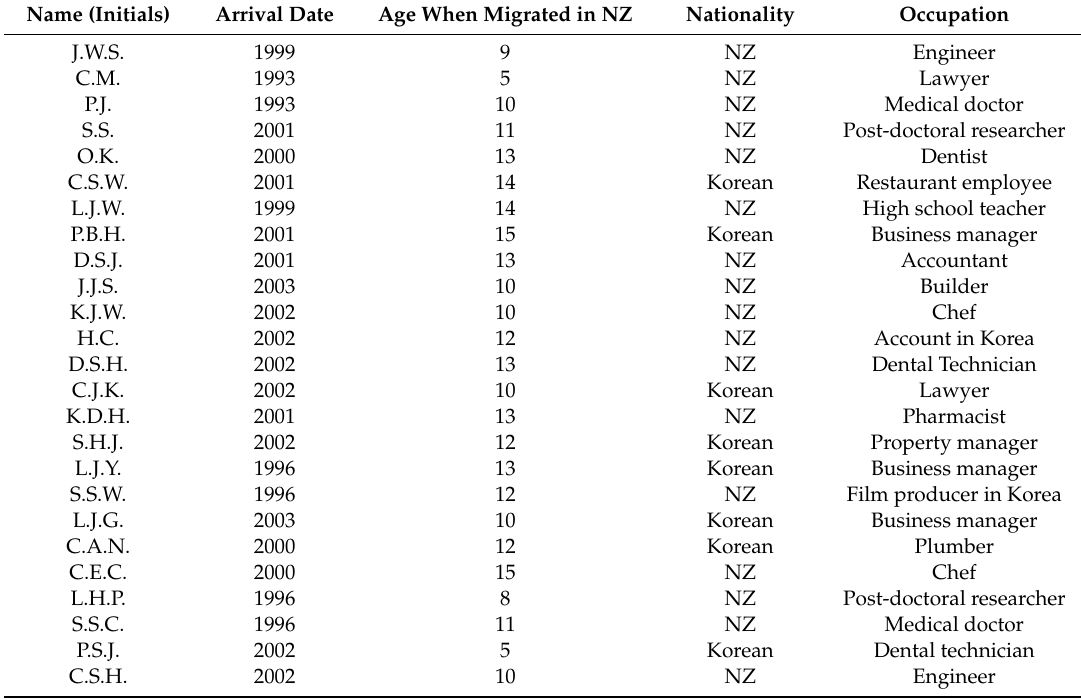
Table 1. Description of the participants.